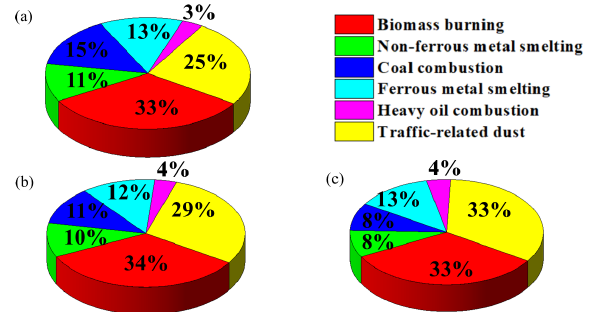
Figure 8. Average contributions of the six sources to the deweath- ered concentrations of the elements in PM 2 . 5 based on the PMF model. The red panel means biomass burning, the green panel de- notes non-ferrous metal smelting, the blue one represents coal com- bustion, the cyan one is ferrous metal smelting, the pink one rep- resents heavy oil combustion, and the yellow one denotes traffic- related dust. (a ), (b) , and (c) represent the source contributions dur- ing 2017–2018, 2018–2019, and 2019–2020,